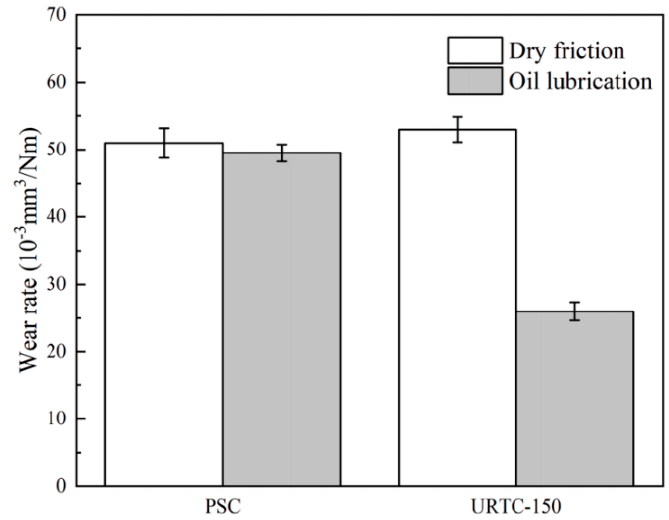
Figure 6. The wear rate of different materials under dry friction and oil lubrication. Reprinted with permission from Ref. [31]. 2021, Elsevier.